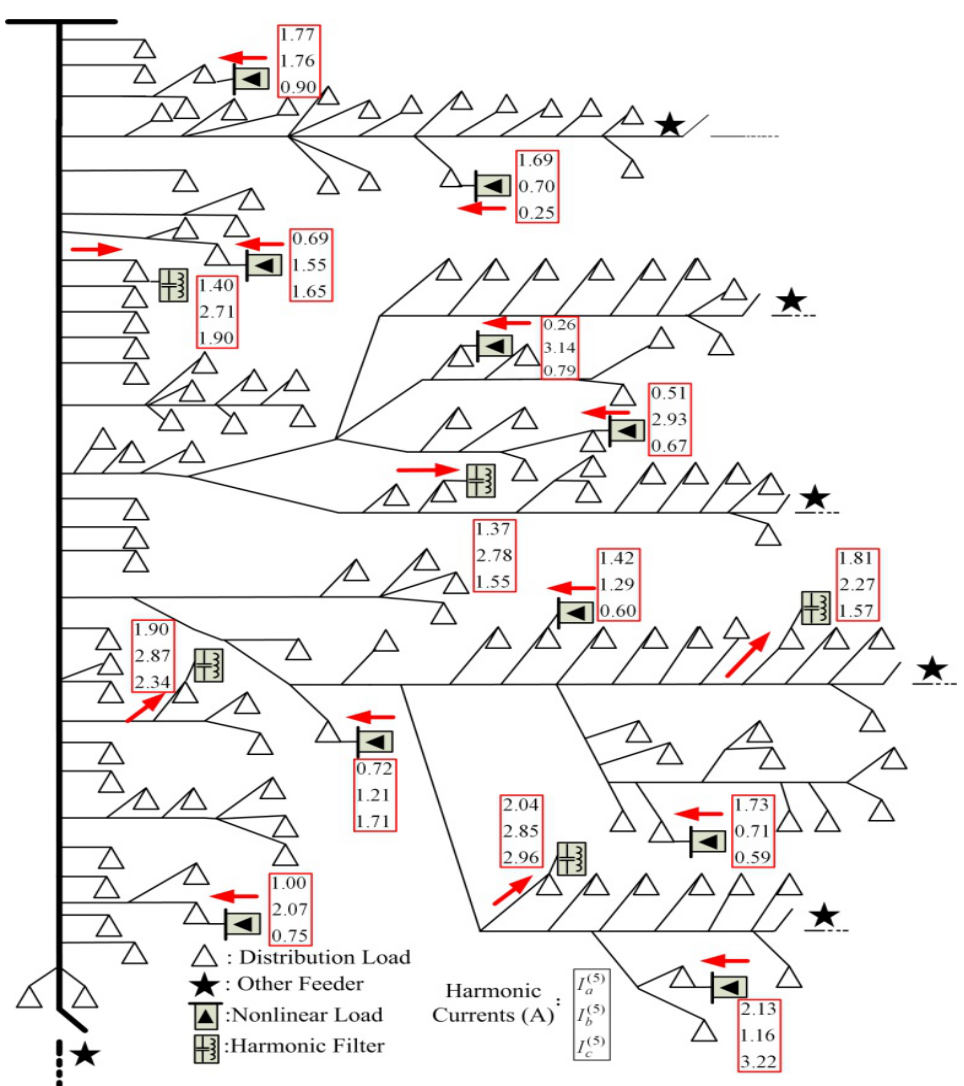
Figure 8. Harmonic currents of the 5 th -order harmonic